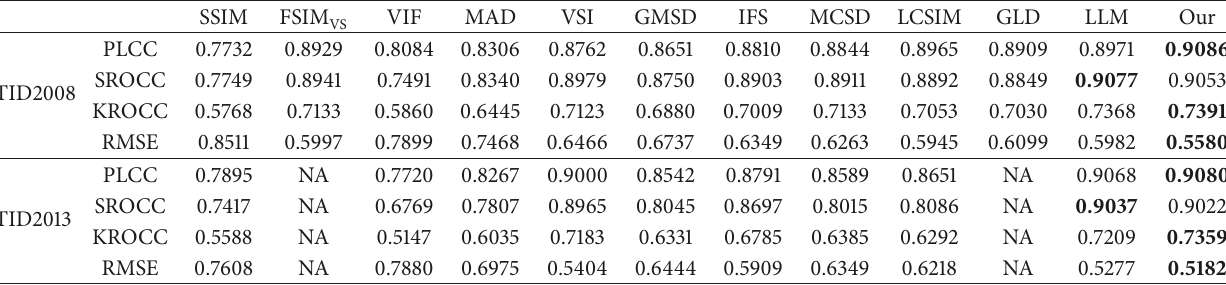
Table 4: Performance comparison on TID databases.